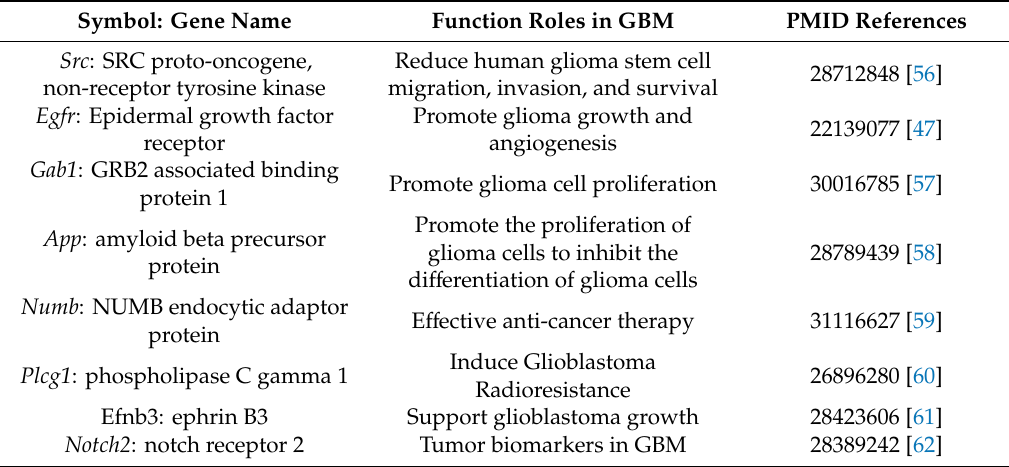
Table 4. The biological functions, corresponding PubMed IDs and literatures for genes with large